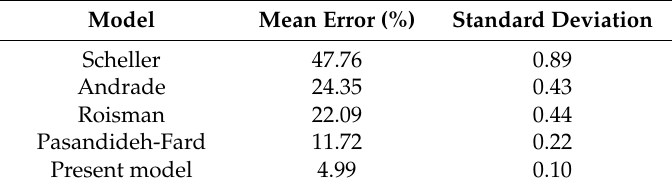
Figure 10. Comparison of the previous models against experimental data. Table 2. Summary of mean-errors and standard deviations of different prediction model.